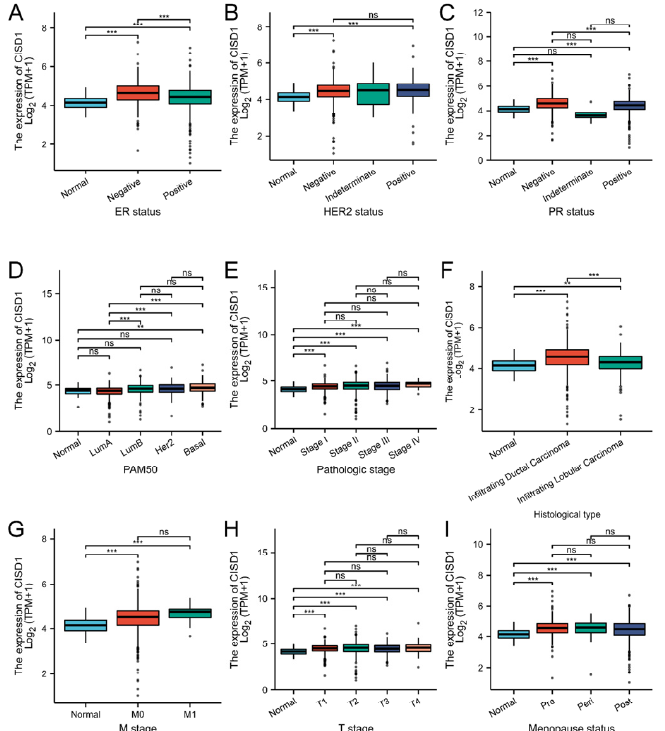
Figure 2. Correlation between the clinical features and CISD1 expression. Boxplots represented correlation between the CISD1 expression and ER status ( A ), HER2 status ( B ), PR status ( C ), PAM50 ( D ), pathologic stage ( E ), histological type ( F ), M stage ( G ), T stage ( H ), Menopause status ( I ). “ns”, “*”, “**”, and “***” represented no significance, p -values < 0.05, 0.01, and 0.001, respectively. Table 1. Breast cancer clinicopathological characteristics and CISD1 expression.